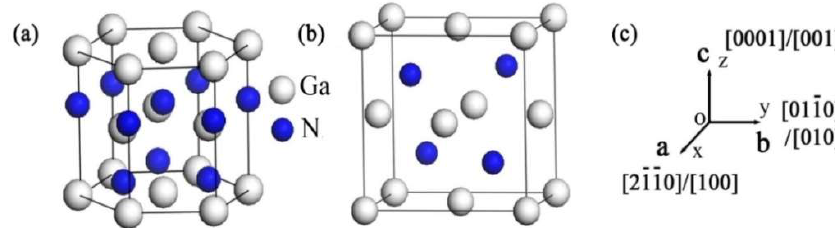
Figure 1. Structures of GaN crystals: ( a ) wurtzite GaN; ( b ) zinc-blende GaN; and ( c ) crystallographic axes and directions.